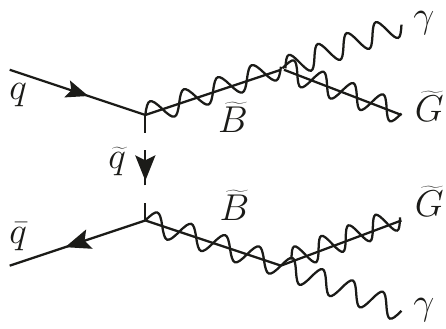
Figure 5 . Bino production through t-channel squarks, which maps to the t-channel mediators of the simpli(cid:12)ed DM